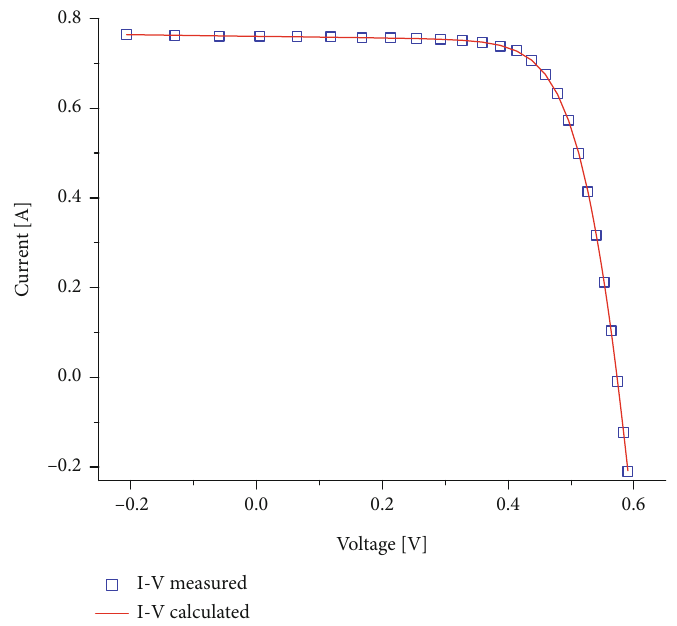
Figure 3: The I-V characteristics for RTC photovoltaic.